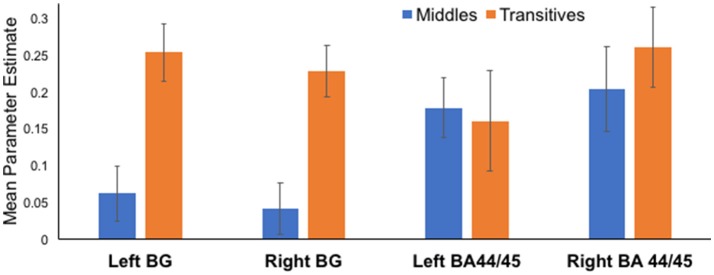
Differential activation for Middles compared to Transitives in basal ganglia and BA 44/45 ROIs. In both left and right basal ganglia ROIs there was marked increase in activation for Transitive compared to Middles. Activation in left and right BA44/45 ROIs was associated with the processing of both types of stimuli.